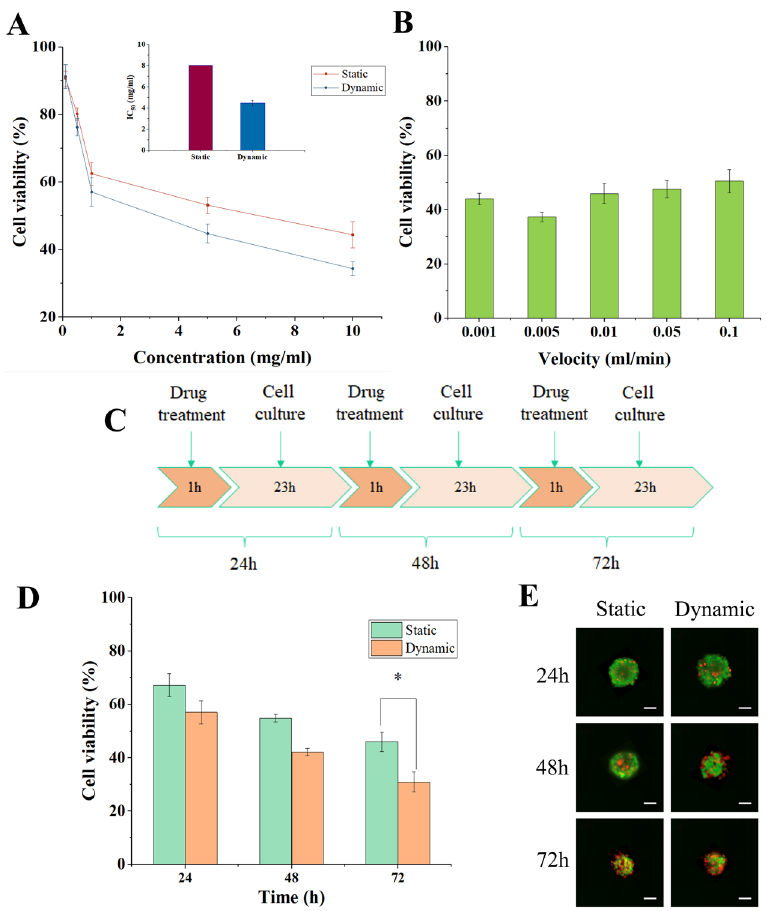
Figure 5. The drug testing on cancer spheroids in the microfluidic device using continuous and intermittent methods. ( A ) Test for concentrations under both static and dynamic culture conditions. The lowest cell viability is 10% at the highest drug concentration of 10 µg/mL in dynamic conditions, while cell viability under static conditions was about 27%. ( B ) Spheroids were treated with a-MG loading GA liposomes for 3h at different velocities and cell viability was strongly attenuated to 50% and 30% at high velocities of 0.1 mL/min and 0.5 mL/min, respectively. ( C ) Intermittent drug testing diagram. ( D ) Intermittent drug testing showed that the cancer spheroids after 72 h were severely degraded to 30% in static conditions. While, in dynamic conditions, cell viability did not remarkably change. It remained at over 90% after the first 24 h of treatment and decreased slightly to nearly 80% after 72 h of treatment. ( E ) Spheroids were also stained with CaAM (Green) and EthD-1(Red) fluorescent dyes using flow and fluorescentl y imaged. (Scale bar = 150 µm). Images were performed in at least 3 separate experiments (* p < 0.05).